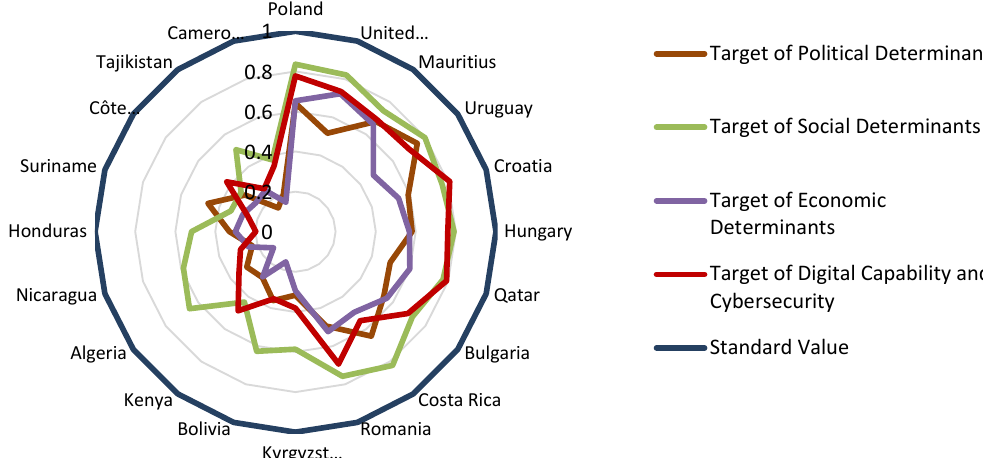
Figure 3. The value of composite targets for economic, social, political, digital capability and cybersecurity dimensions for developing countries. Source: Authors’ calculations